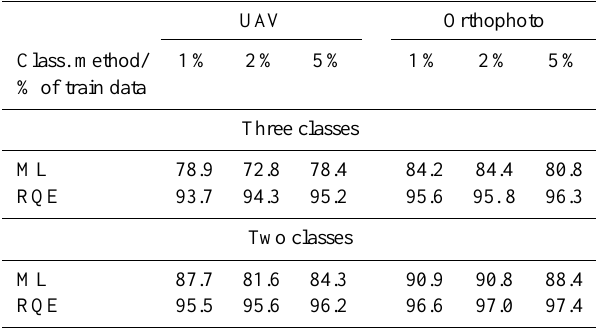
Table 1. RQE vs. ML method: overall classification accuracies (in %). Boosting with RQE features after 500 iterations. Maximum likelihood classifier was trained with features consisting of single raw pixel intensities (all spectral